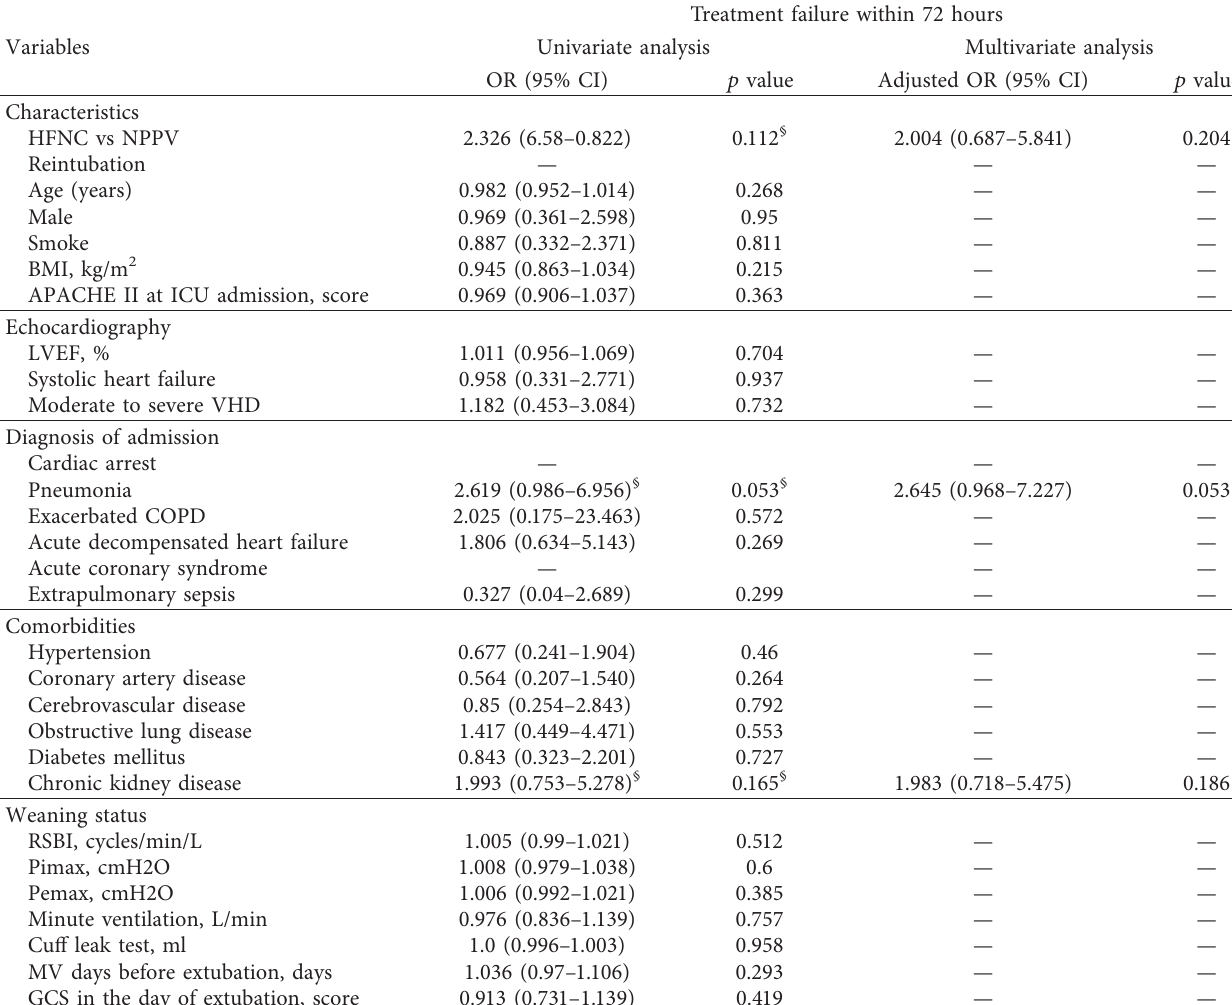
Table 3: Univariate and multivariate analyses of variables associated with treatment failure and hospital